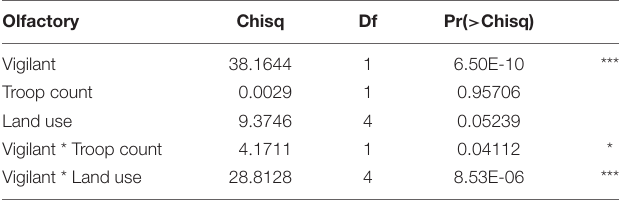
TABLE 4 | Post hoc analysis of deviance, Type II Wald chi-square tests for model fixed effects.